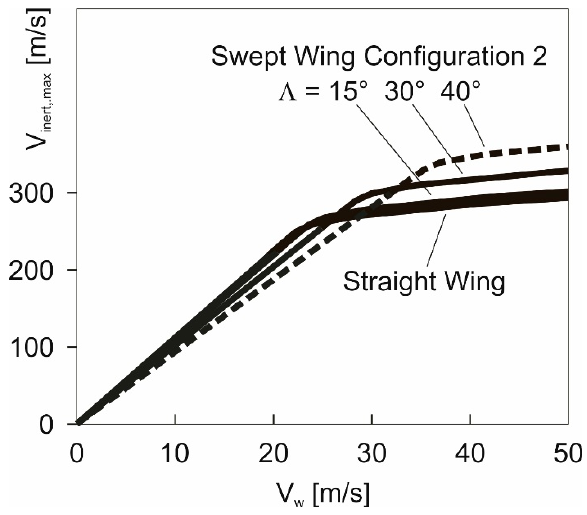
Figure 16. Effect of wing sweep on maximum speed, 𝑉 (cid:3036)(cid:3041)(cid:3032)(cid:3045)(cid:3047),(cid:3040)(cid:3028)(cid:3051) , for swept wing configuration 2.